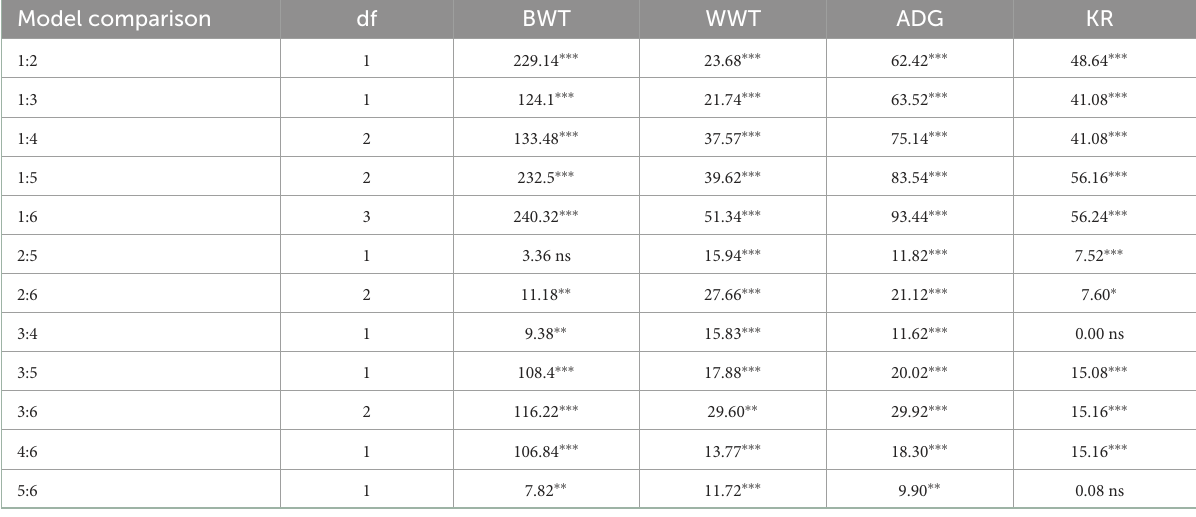
TABLE 5 Likelihood ratios and χ 2 test results of different model comparisons. Model comparison